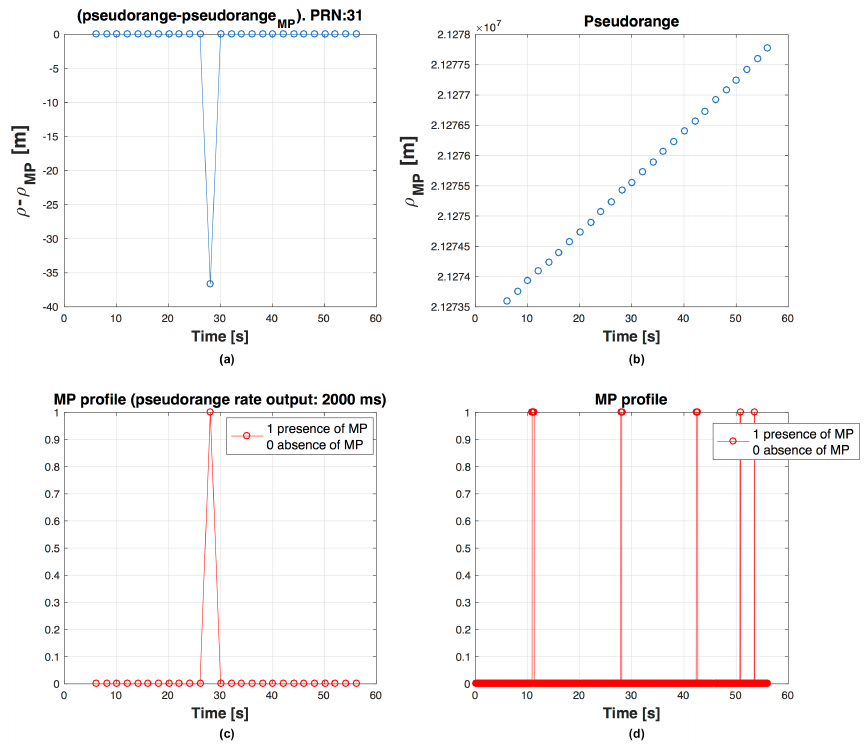
Figure 6. Behaviour of PR for PRN 31, with output every ∆ T ρ = 2000 ms. PR error ( ρ clean − ρ MP ) ( a ); ρ MP trend in time ( b ); MP presence during a PR computation ( c ) and MP profile ( d ) are